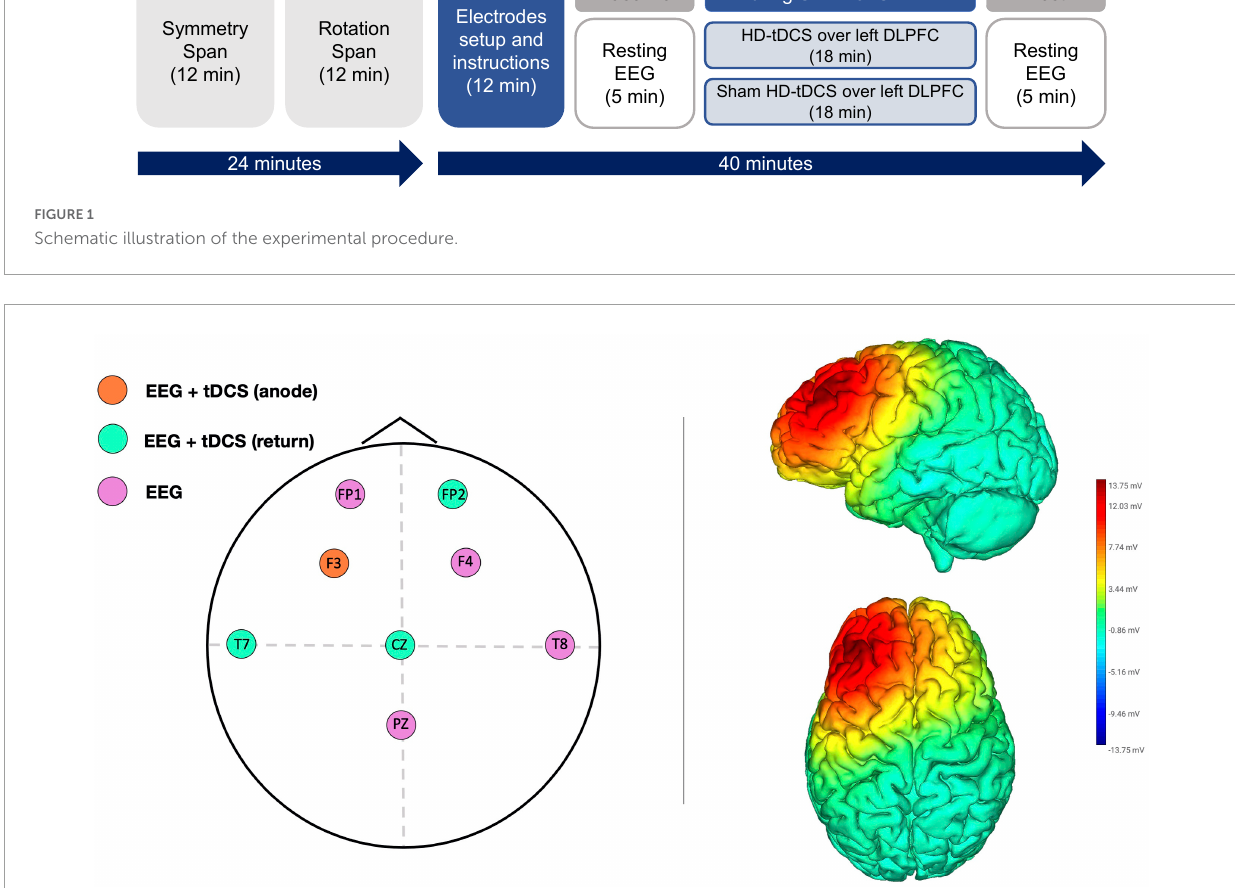
FIGURE2 Electrode configuration for EEG recording and HD-tDCS montage according to the international EEG 10–20 system (left panel) . Simulation of the electric voltage field for HD-tDCS (right panel)